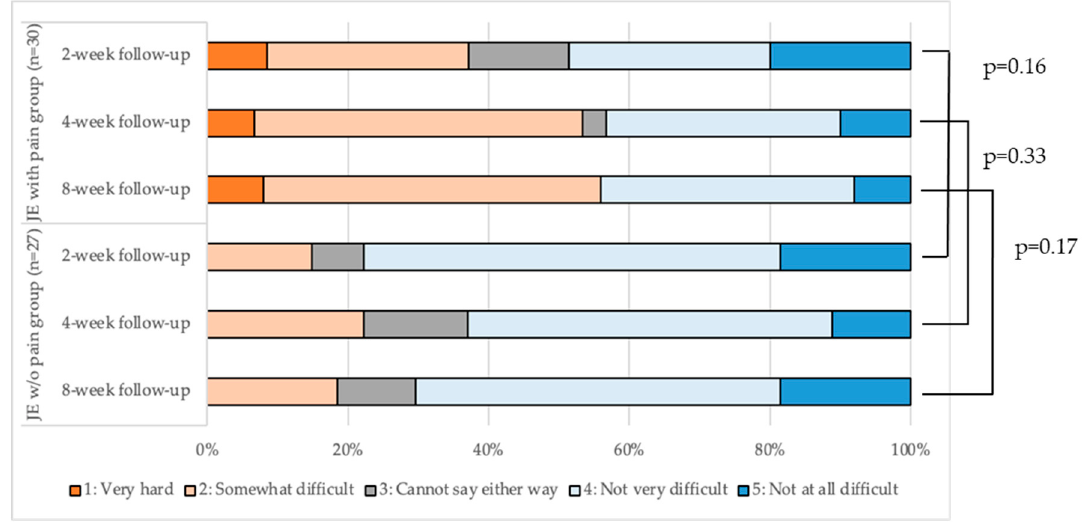
Figure 4. Evaluation of the difficulty of jaw-opening exercise in the two groups.